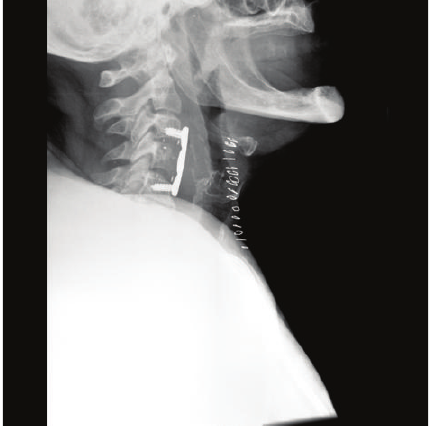
Figure 5: Postoperative lateral radiograph of the cervical spine showing a stable anterior C3–C5 stabilization using a cage and an anterior